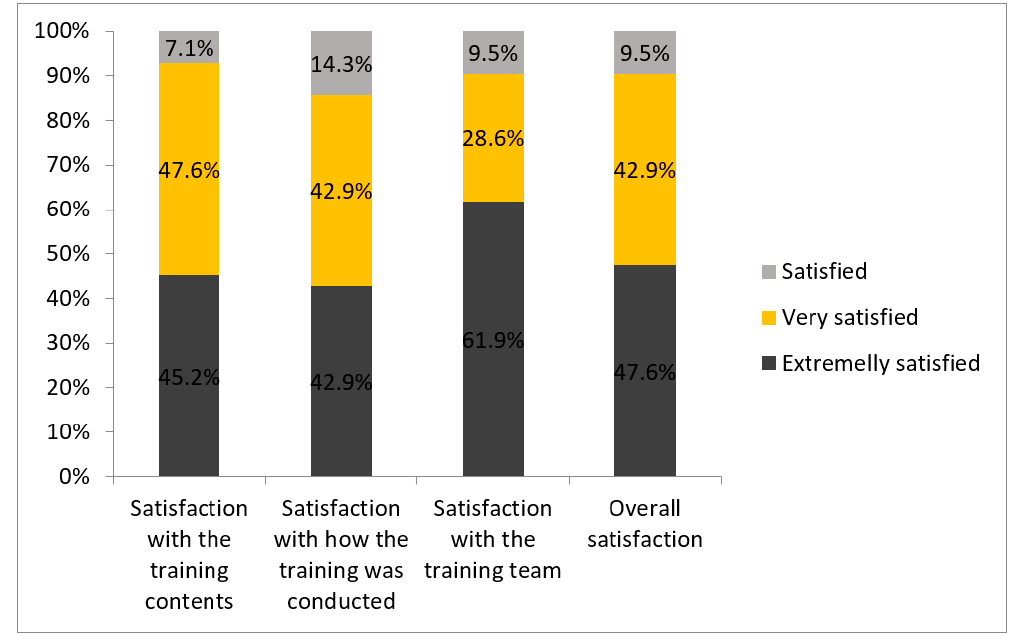
Figure 1. Trainees’ satisfaction with the “Health in Equality” program.